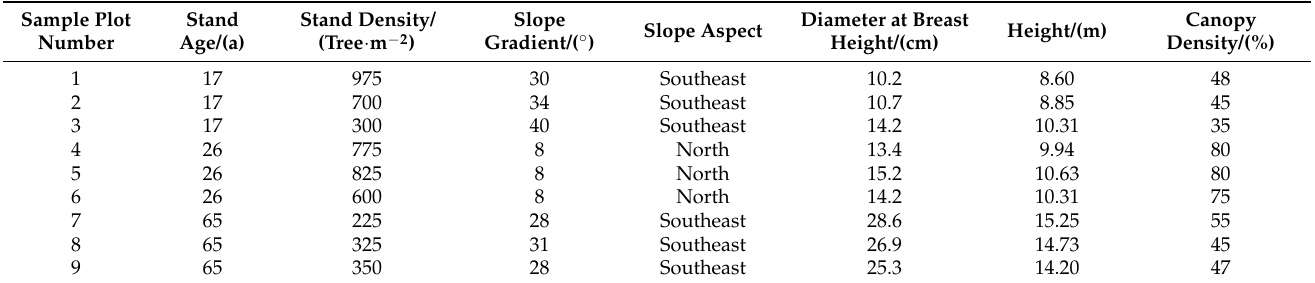
Table 1. Basic characteristics of sampling plots